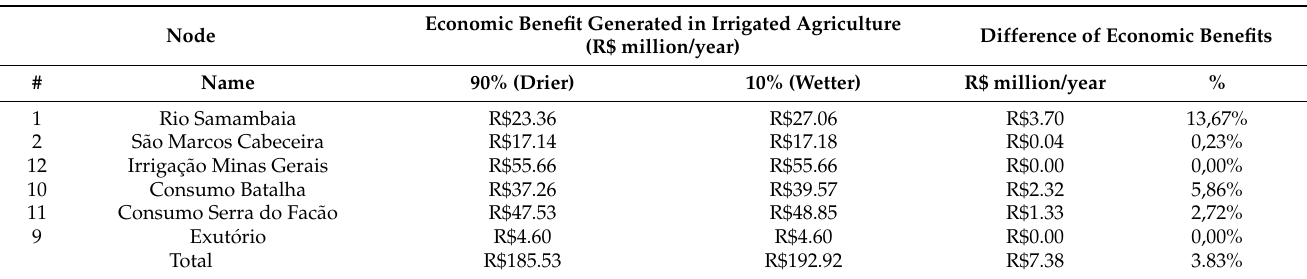
Table 4. Economic benefit generated by irrigated agriculture in both scenarios for each node in the economic arrangement.